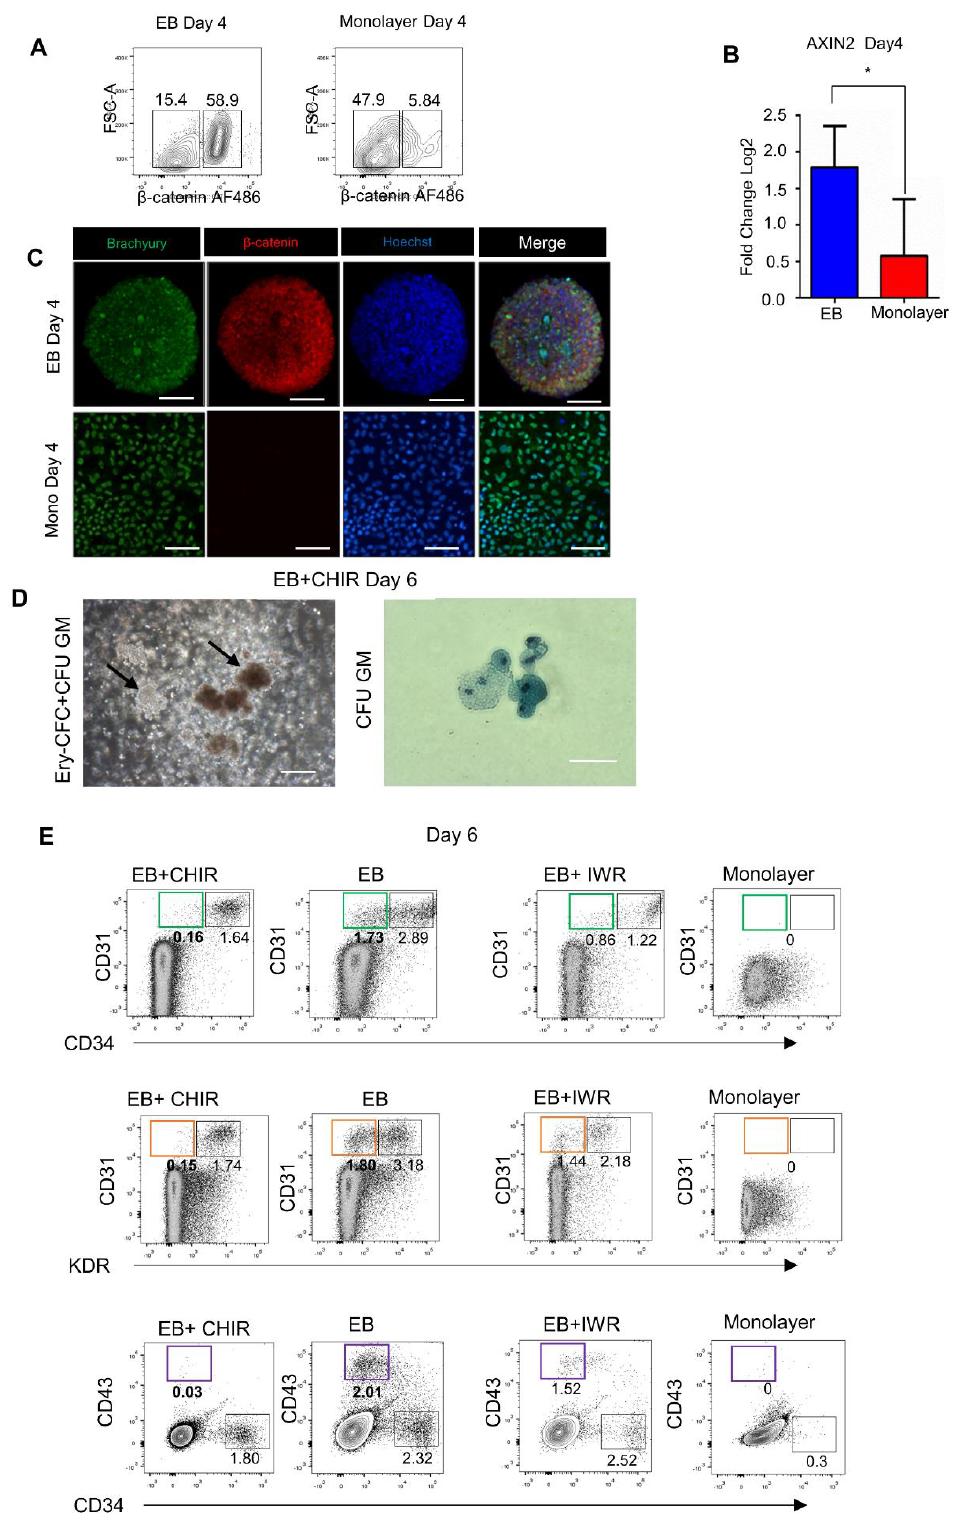
Figure 4. Endogenous activity of Wnt/β -catenin signaling in 3D/EB and 2D/Monolayer cells on day 4 of PSC differentiation. ( A ) Representative flow cytometry analysis of Day 4 cells, comparison of β -catenin-positive cells determined by FACS, and ( B ) Quantitative PCR analysis of Axin2, and ( C ) Immunofluorescence of Brachyury and β - catenin. Scale Bars: 100 μm, (Mean ± SEM) n = 3, * p ≤ 0.05.